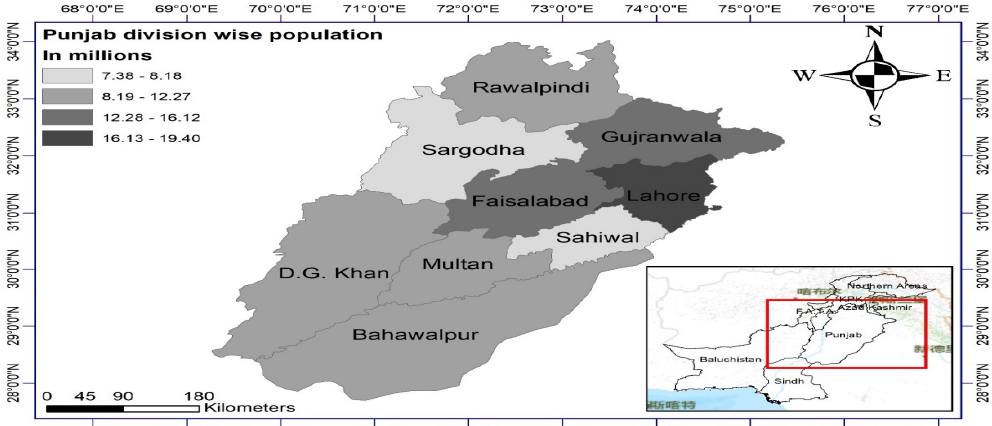
Fig. 2: Location Map of Punjab, Pakistan and Division Wise Population Distribution (As per Pakistan National Census